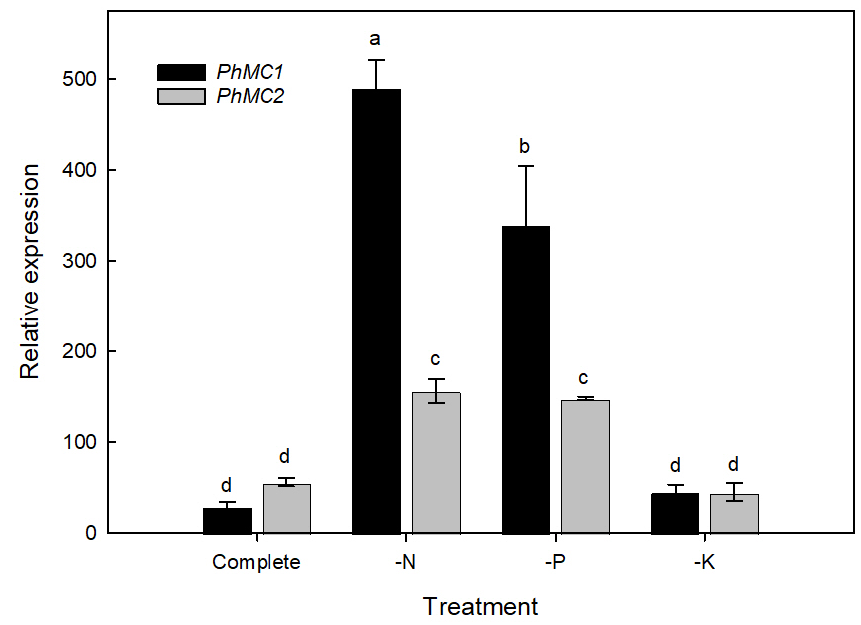
Figure 7. Metacapase gene expression in petunia leaves following nutrient deprivation. Petunia × hybrida ‘Mitchell Diploid’ plants were grown in nutrient deficient solutions for 4 weeks. Solutions contained either complete nutrients or were deficient in N, P, or K. After 28 days of nutrient stress, leaf tissue was harvested and analyzed for relative mRNA abundance of PhMC1 and PhMC2 by quantitative PCR. Transcripts were expressed relative to PhACTIN . Bars represent mean ± SD, n = 3. Different letters represent statistically significant difference between the means ( p ≤